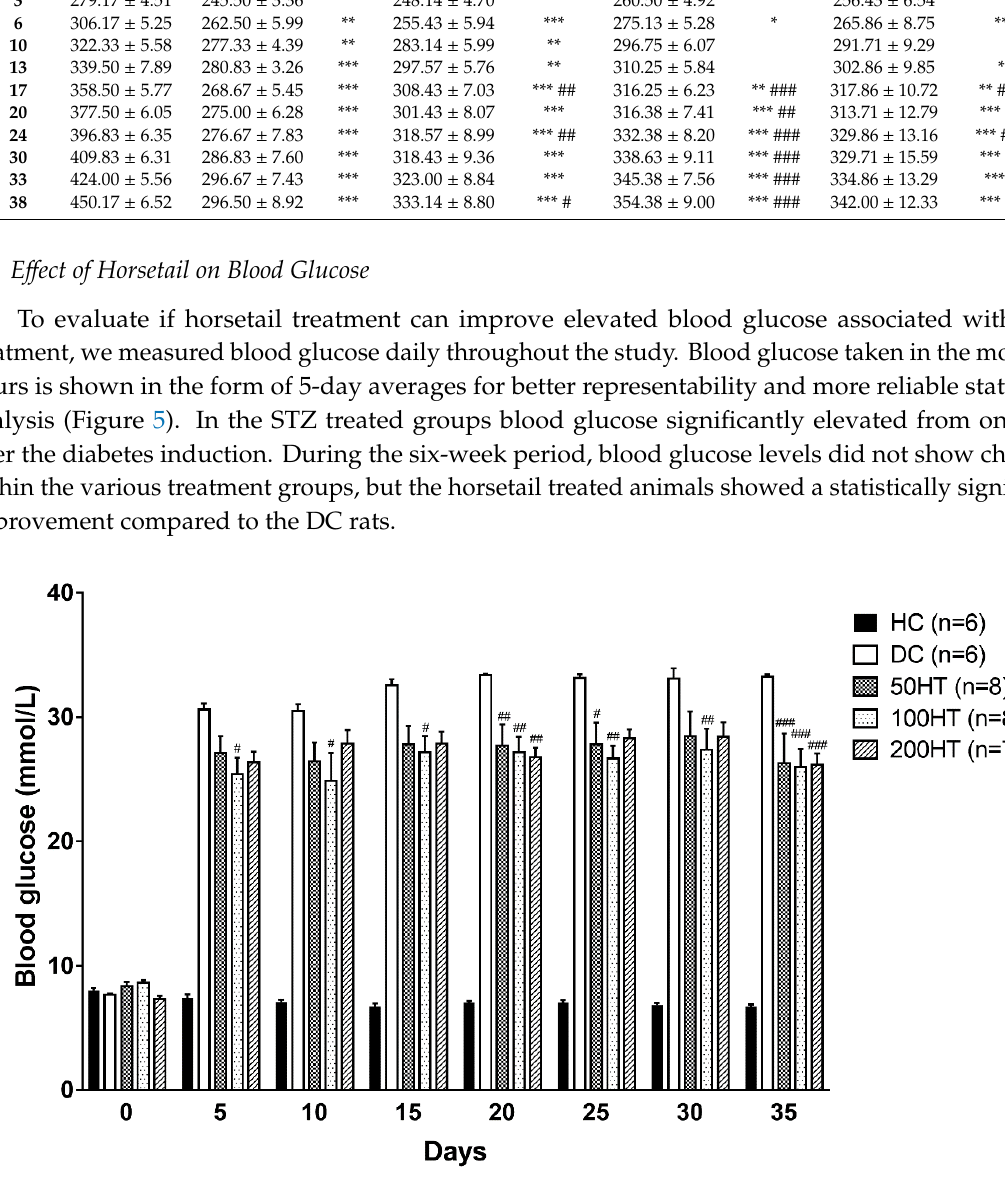
Figure 5. Effect of horsetail on blood glucose. From day 1, all groups showed a significant difference from the HC group ( p < 0.001). For clearer representability it is not shown with symbols. The #, ##, and ### indicates significant difference from the DC group ( p < 0.05, p < 0.01, and p < 0.001, respectively).